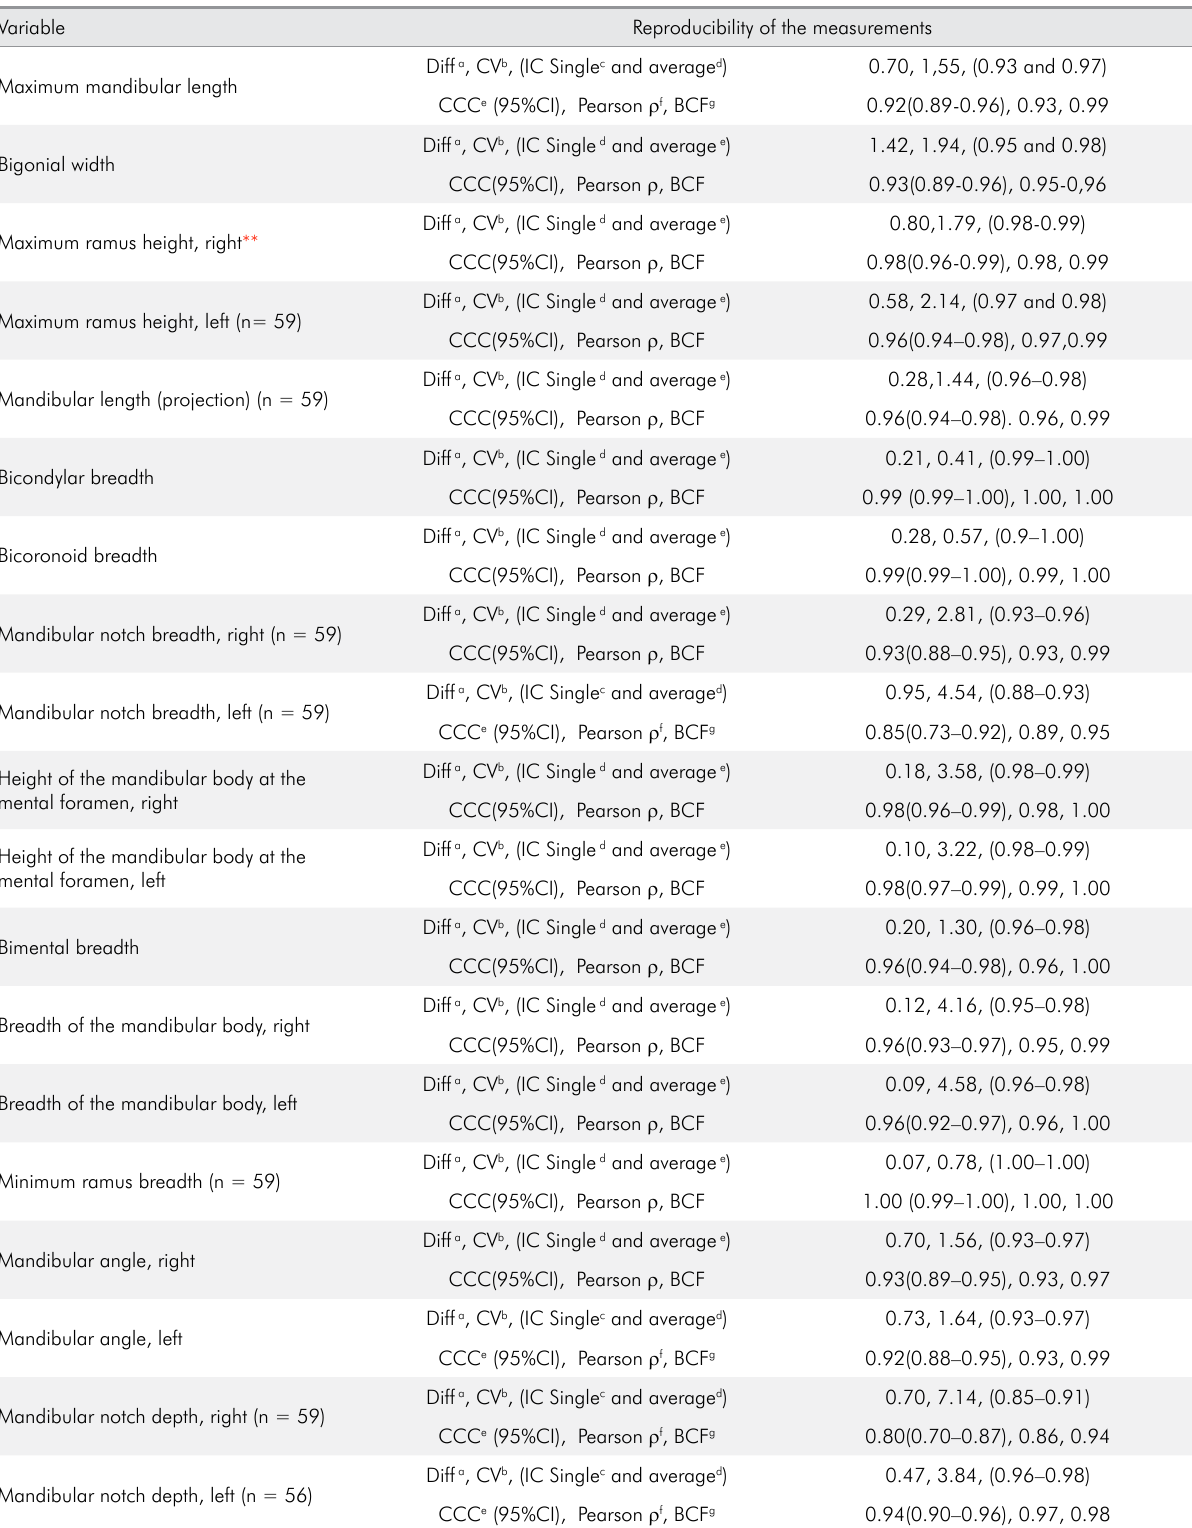
Table 3. Reproducibility of the measurements per